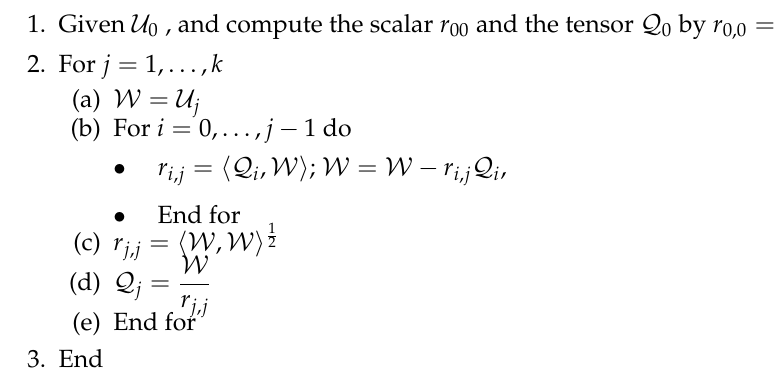
Algorithm 3 The global-QR